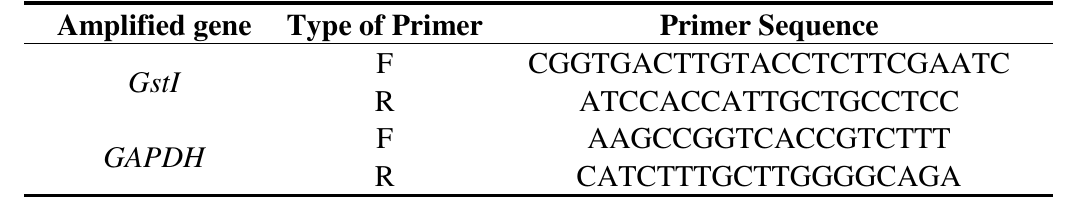
Table 3. Sequences of TaqMan ® fluorescent probes designed for amplification of GstI